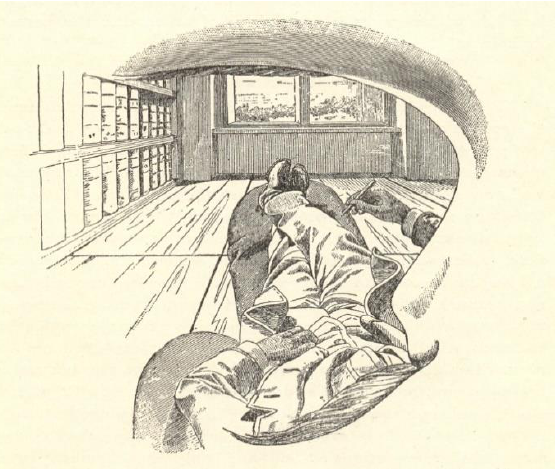
Figure 1. Ernst Mach’s first-person self-portrait [29] (p. 59). Reproduced with permission of the Oxford University Press.